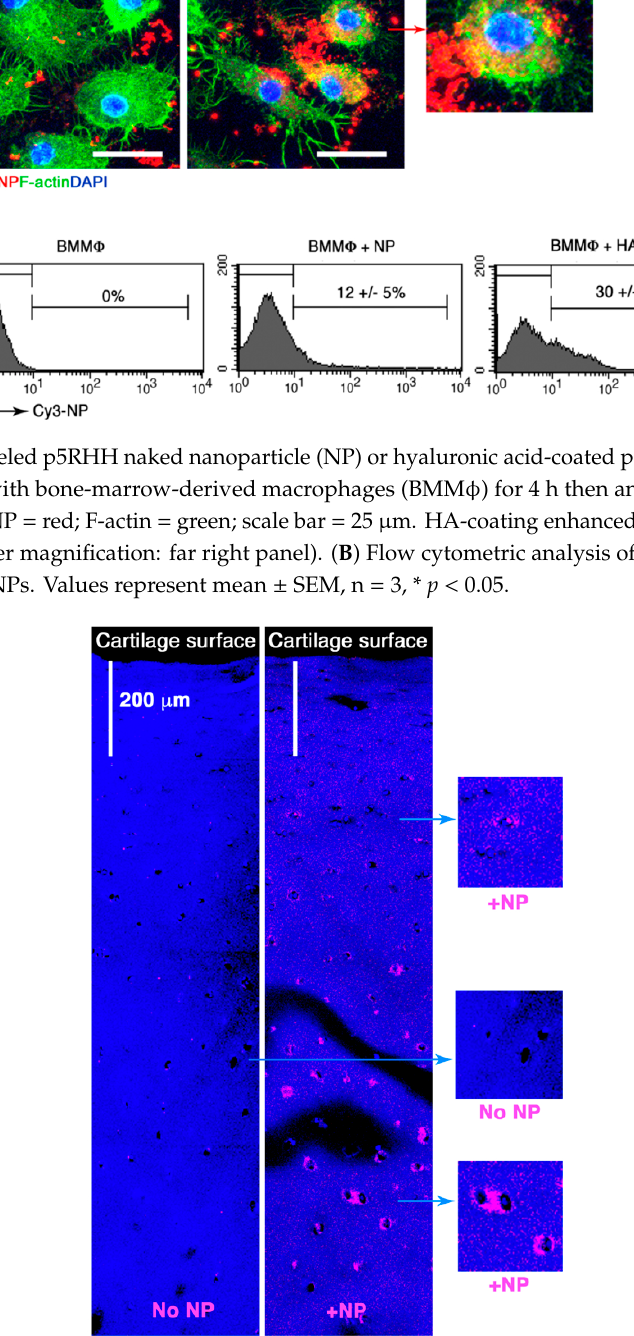
Figure 2. Cy3-labeled HA-NPs (~55 nm) were incubated with 5 mm 2 cartilage discs from human OA knee. After 48 h, cartilage explants were washed, processed, and examined for depth of NPs penetration by confocal microscopy. The HA-NPs deeply penetrated the cartilage explants (up to ~1 mm in depth).